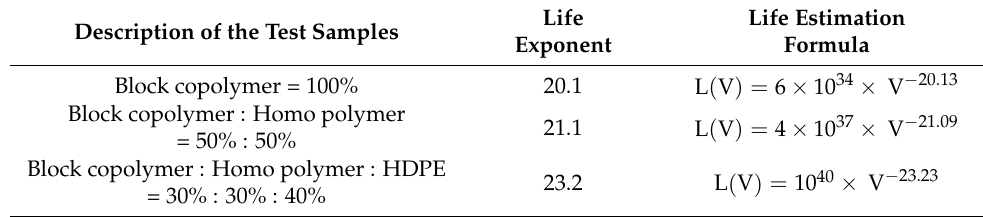
Table 3. The life exponent and life estimation formula according to